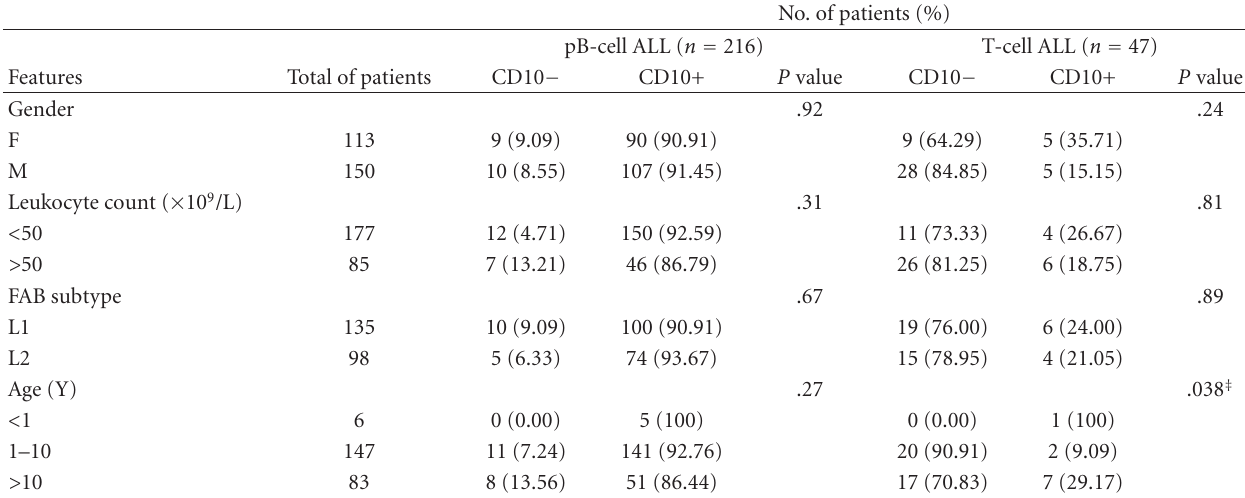
Table 4: Clinical and biological features according to CD10 expression in children with